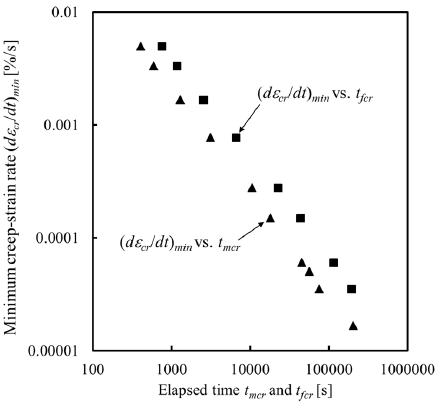
Figure 8. Minimum creep-strain rate ( d ε cr / dt ) min versus elapsed time until creep-strain rate reached minimum t mcr (triangles) and creep life t fcr (circles).